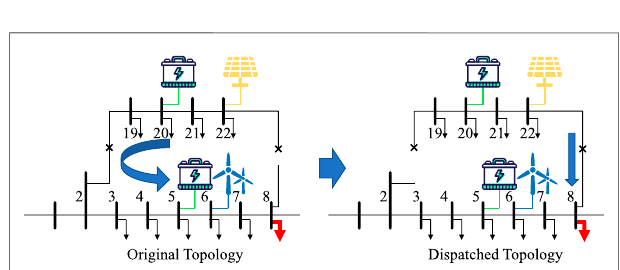
FIGURE 7 | Dispatch actions to reduce transmission cost.